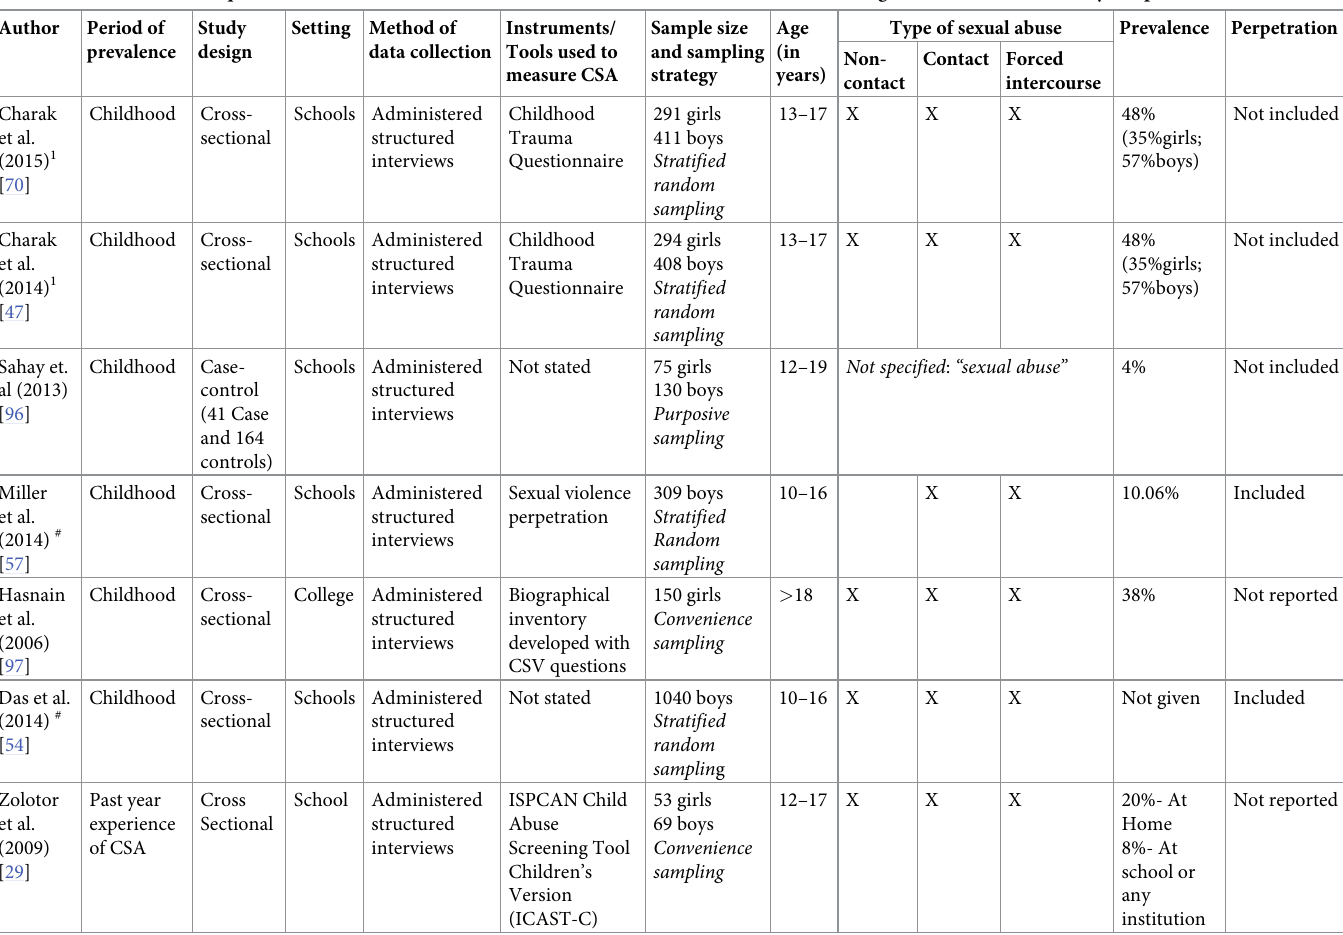
Table 2. Characteristics of quantitative and mixed-method studies included in the review with school/college, clinical, and community